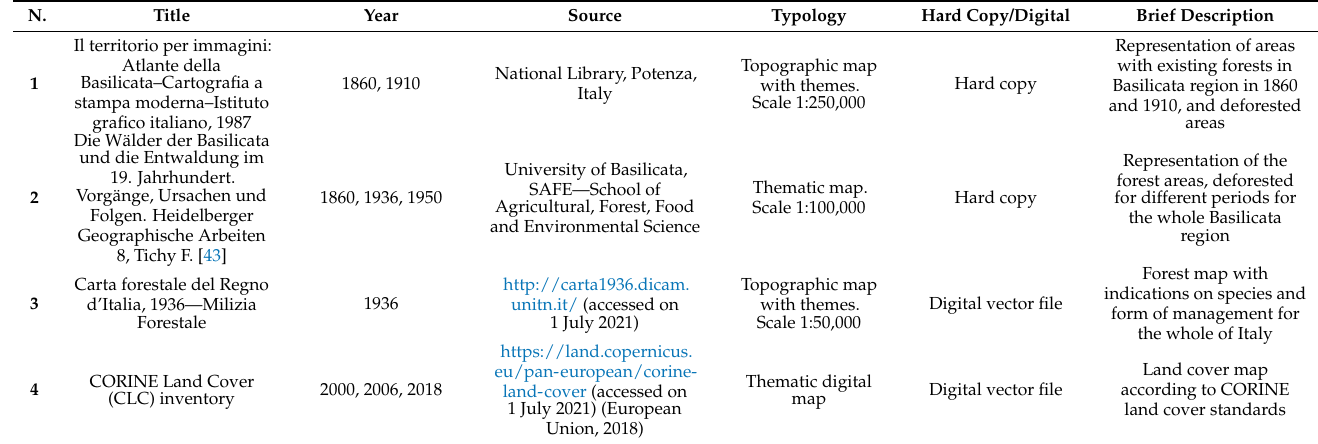
Table 1. Cartographies and datasets used in this study.